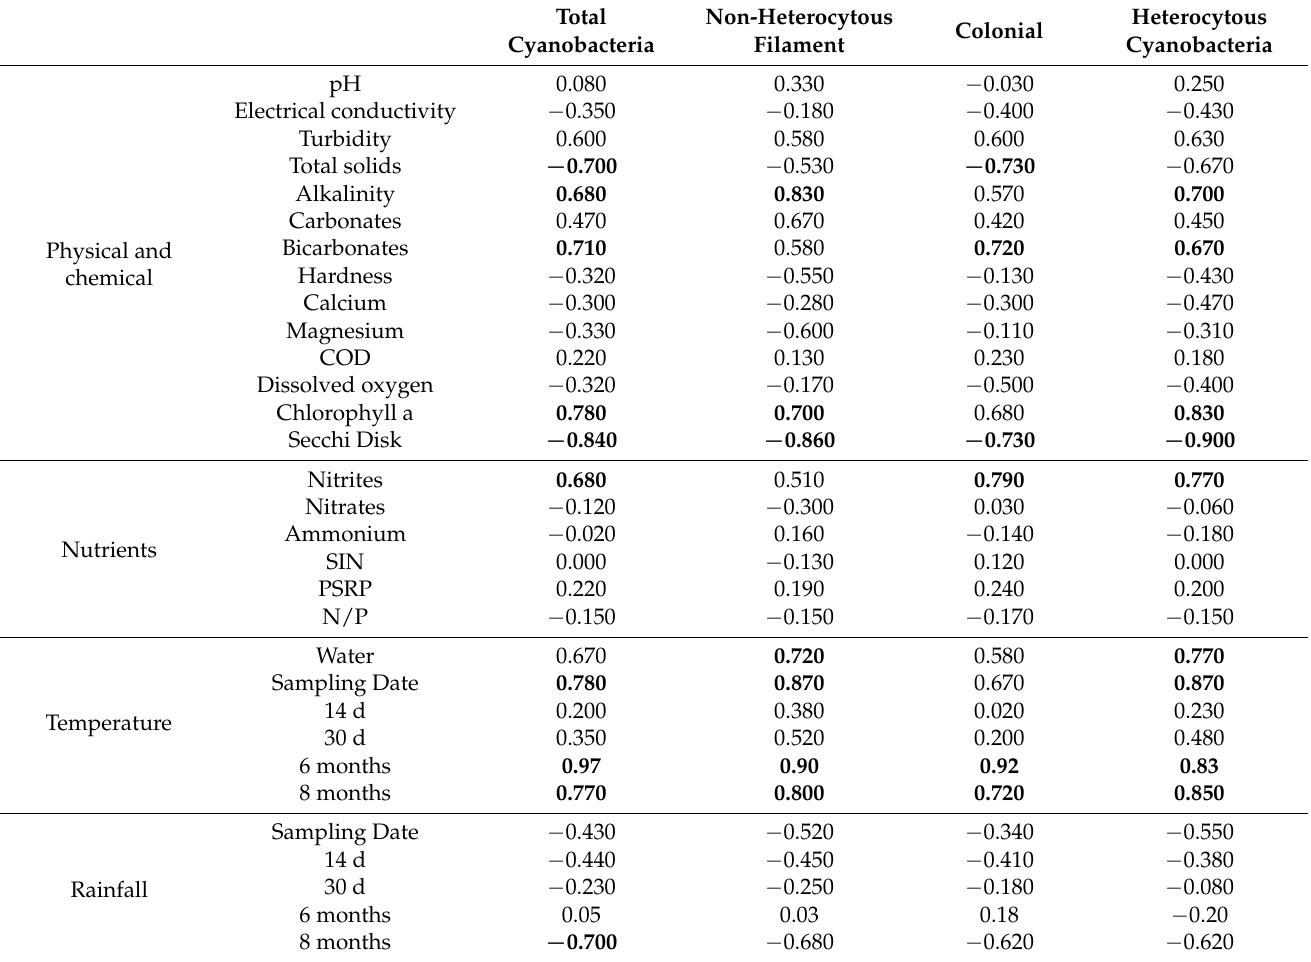
Table 2. Spearman correlations coefficients between physical, chemical, metereological, and cyanobac- terial abundances. Statistically significant coefficients are indicated in bold ( p < 0.05). * The sampling date refers to the temperature or precipitation recorded on the day the sample was taken. Total Non-Heterocytous Heterocytous Colonial Cyanobacteria Filament